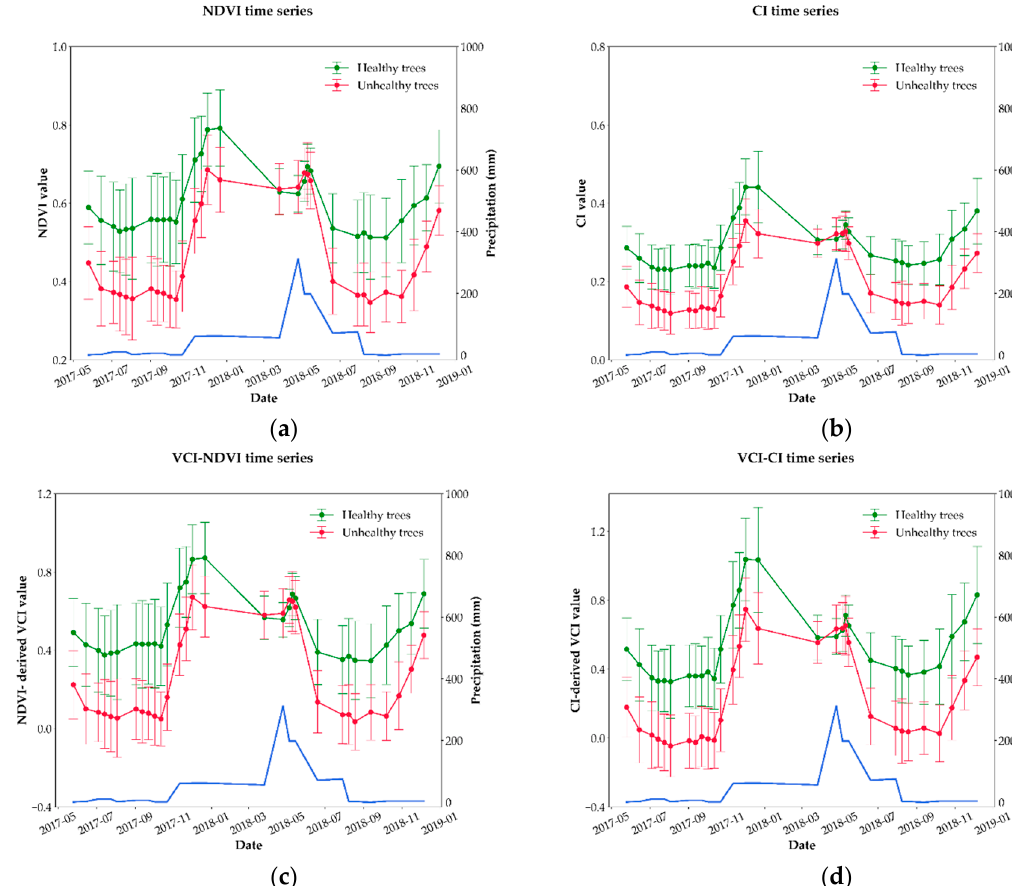
Figure 7. Healthy (green) and unhealthy (red) cork oak trees temporal variability computed based on the NDVI ( a ), CI ( b ), NDVI-derived VCI ( c ), and CI-derived VCI ( d ) indices. Monthly precipitation values (blue line), obtained from the Magos Dam weather station, are superimposed to the NDVI time series calculated for the HMG test